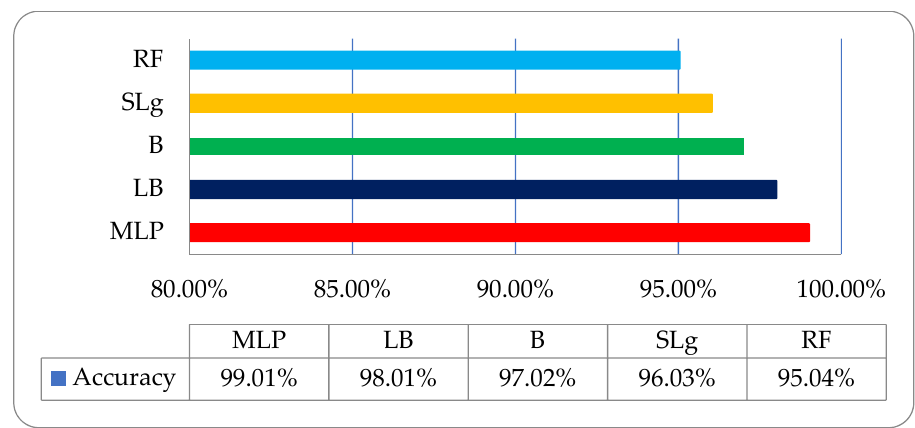
Figure 9. Medicinal plant leaves classification graphic on ROI’s (280 × 280). The Confusion Matrix (CM) of MLP classifier on fused medicinal plant leaves dataset using ROO’s size 280 × 280. The diagonal cells contain the number of correctly identified plants and the rest of the cells contain the number of misclassified plants. This CM is presented in Table 5. Table 5. CM showing medicinal plant leaves classification on ROO’s size (280 × 280) using MLP.